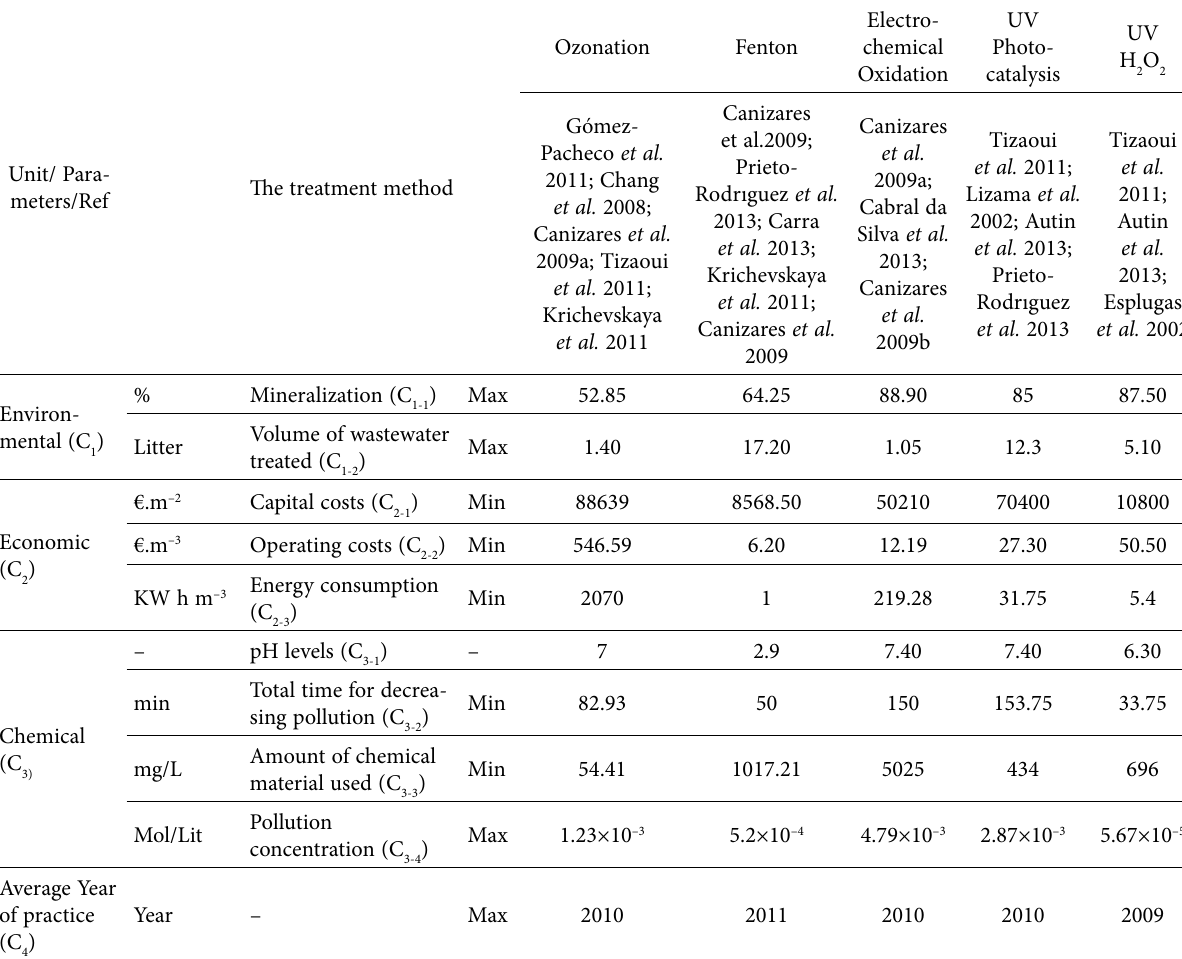
Table 2. Environmental, economical and chemical factors for five AOPs